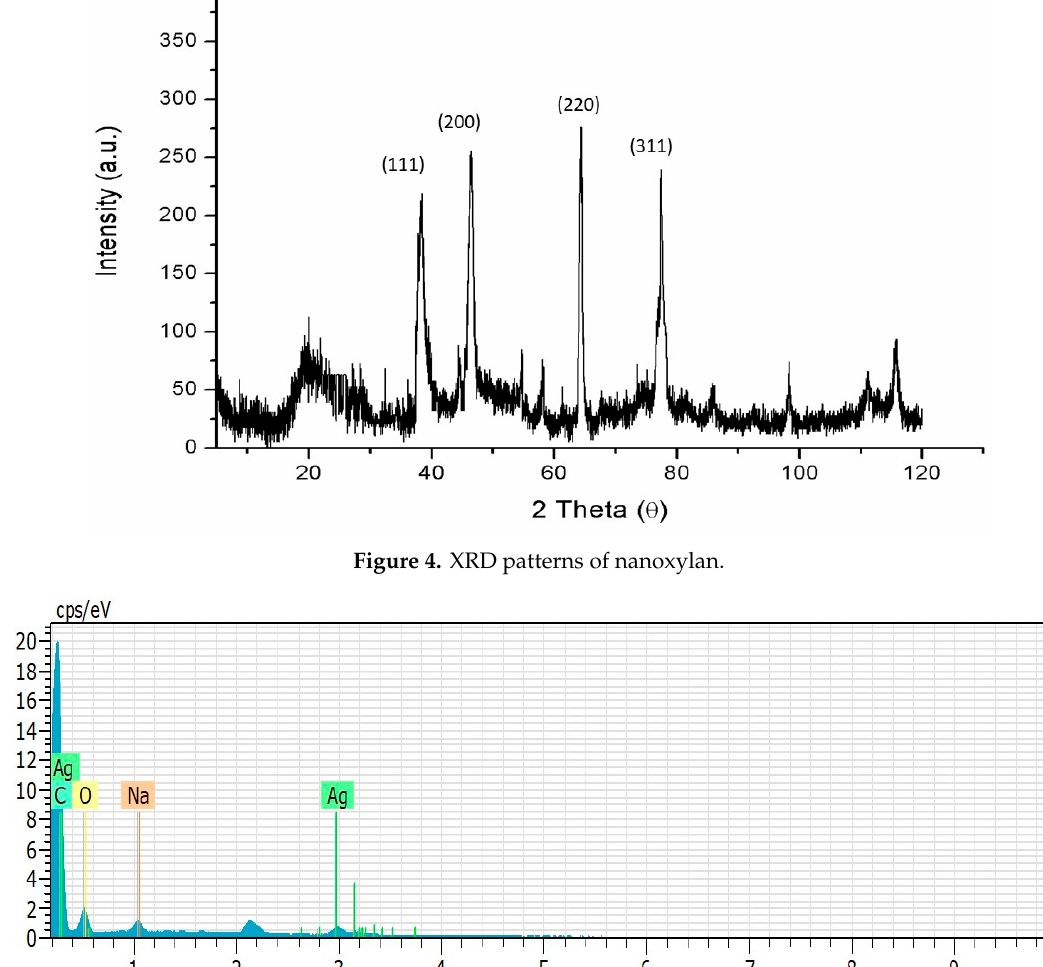
Figure 5. Energy dispersive X-ray spectroscopy (EDS) spectrum of nanoxylan. Table 2. Energy dispersive X-Ray spectroscopy elemental composition of nanoxylan. Carbon (%)